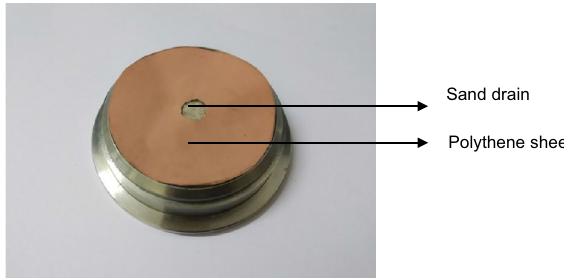
Fig. 2 Radial drainage using sand